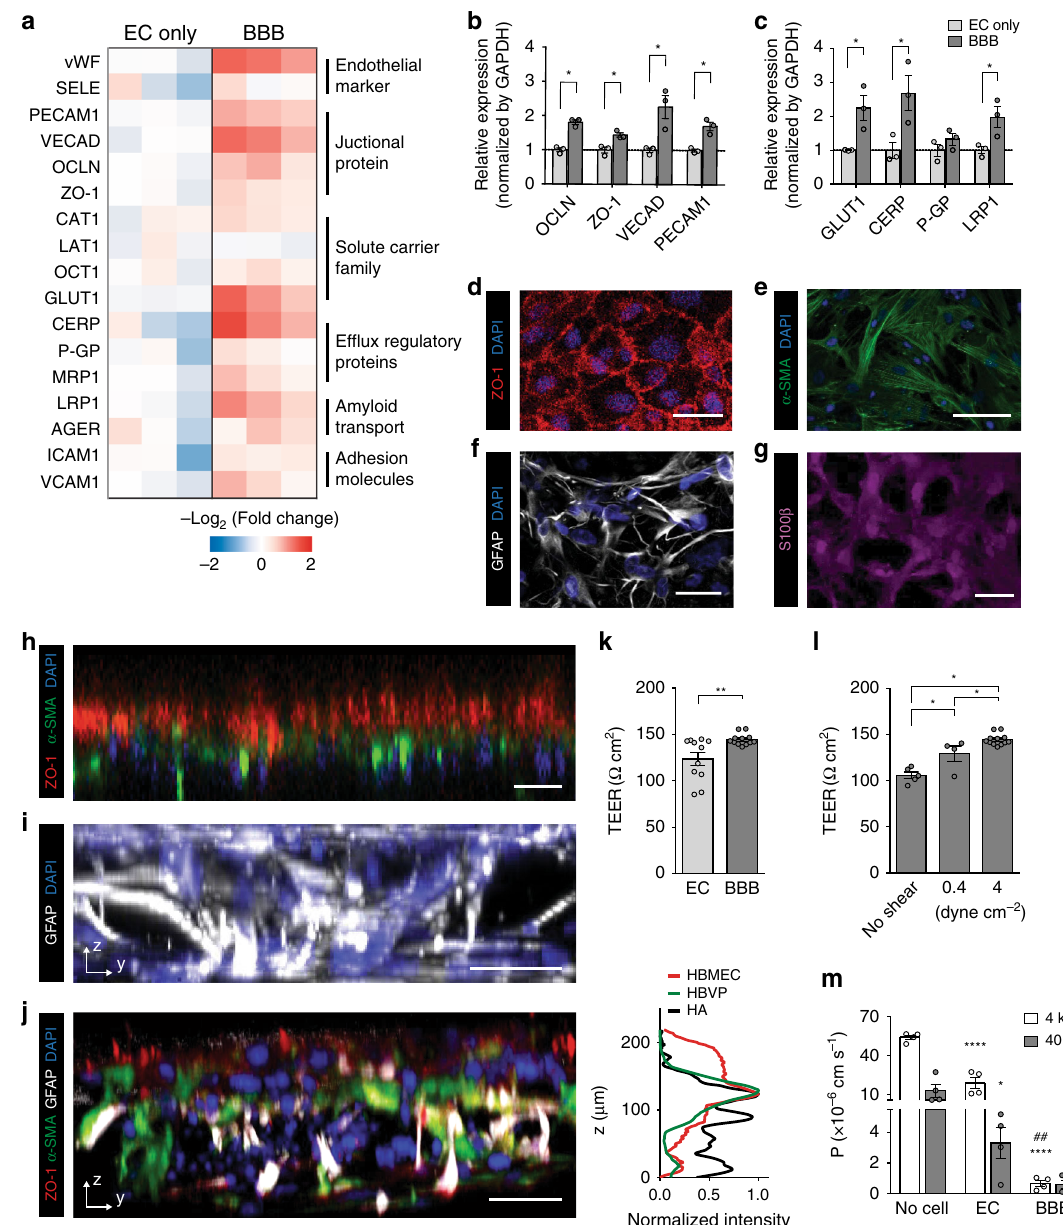
Fig. 2 Barrier integrity of the endothelial monolayer for the BBB chip. a Heat map of RT-qPCR results of HBMECs in mono-culture and tri-culture systems ( n = 3 for each condition). b , c Gene expression of HBMECs in mono-culture and tri-culture systems including junctional proteins ( b ) and receptor proteins ( c ) ( n = 3 for each condition, * p < 0.05 by student t -test). d Tight endothelial monolayer (ZO-1, red; DAPI, blue) formed in the upper channel of the device. e Pericytes cultured underneath the porous membrane where an endothelial monolayer is constructed on the other side ( α -SMA, green; DAPI, blue). f , g Astrocytes with star-shaped morphology labeled with GFAP (GFAP, white) ( f ) and S100 β (S100 β , magenta) ( g ). h Bi-layer of an endothelial monolayer (ZO-1, red) and HBVPs ( α -SMA, green). i Astrocytic end-feet stretching to the endothelium in 3D cellular network (GFAP, white; DAPI, blue). j 3D BBB structure constructed in a device (ZO-1, red; α -SMA, green; GFAP, white; DAPI, blue). The fl uorescence intensity pro fi les indicate the distribution of ZO-1, α -SMA, and GFAP in the image. k Transendothelial electrical resistance (TEER) measured across the membrane between the upper and lower layers with an endothelial monolayer (EC) and an endothelial monolayer with pericytes and astrocytes (BBB) ( n = 11 for EC and n = 12 for BBB, ** p < 0.01 by student t -test). l TEER measured from BBB models under different levels of shear stress ( n = 5 for No shear, n = 4 for 0.4 dyne cm − 1 , and n = 12 for 4 dyne cm − 2 , * p < 0.05 by student t-test). m Permeability coef fi cients calculated from the diffusion of 4 kDa and 40 kDa FITC-dextran through a membrane (No cell), an endothelial monolayer (EC), an endothelial monolayer co-cultured with pericytes and astrocytes (BBB) ( n = 4 for each condition, * p < 0.05 and **** p < 0.001 vs. No cell, # p < 0.05 and ## p < 0.01 vs. EC, all by student t -test). Data are presented as mean ± s.e.m. All scale bars = 50 µ m. All images are representative ones from at least fi ve biological and three technical